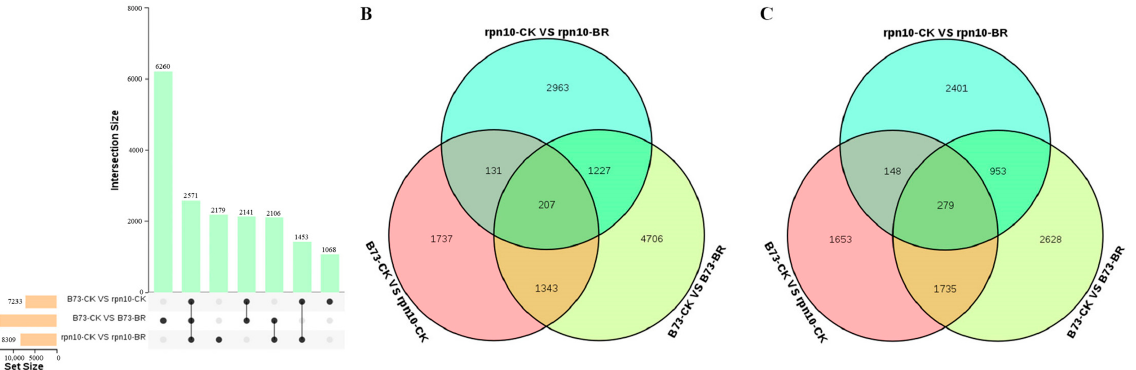
Figure 4. The number of differential genes under different materials and BR (A) Upset plot analysis of all DEGs under different materials and BR treatments; (B) Up-regulated DEGs identified under different materials and BR treatments; (C) Down-regulated DEGs identified under different materials and BR treatments. Columns represent DEG under single or multiple processes, the x-axis represents combinations of different groups (black dots represent single-treatment comparisons, black lines connected by dots represent multi-treatment comparisons), and the y-axis represents the number of genes corresponding to combinations.